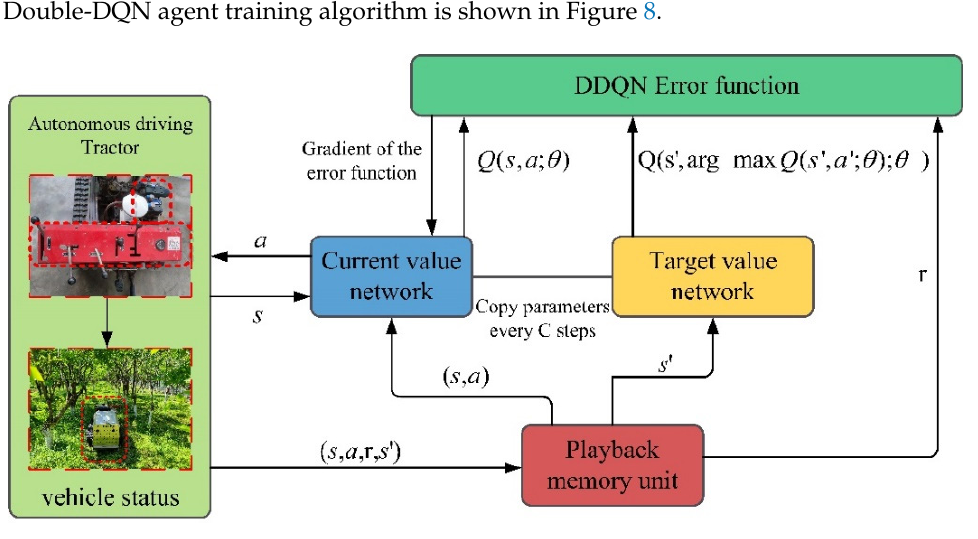
Figure 7. Schematic illustration of the Double-DQN network. Table 2. List of hyperparameters and their values.